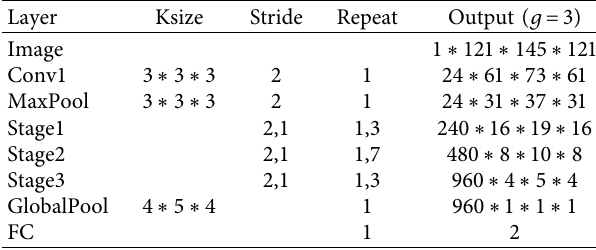
Table 1: Model structure of